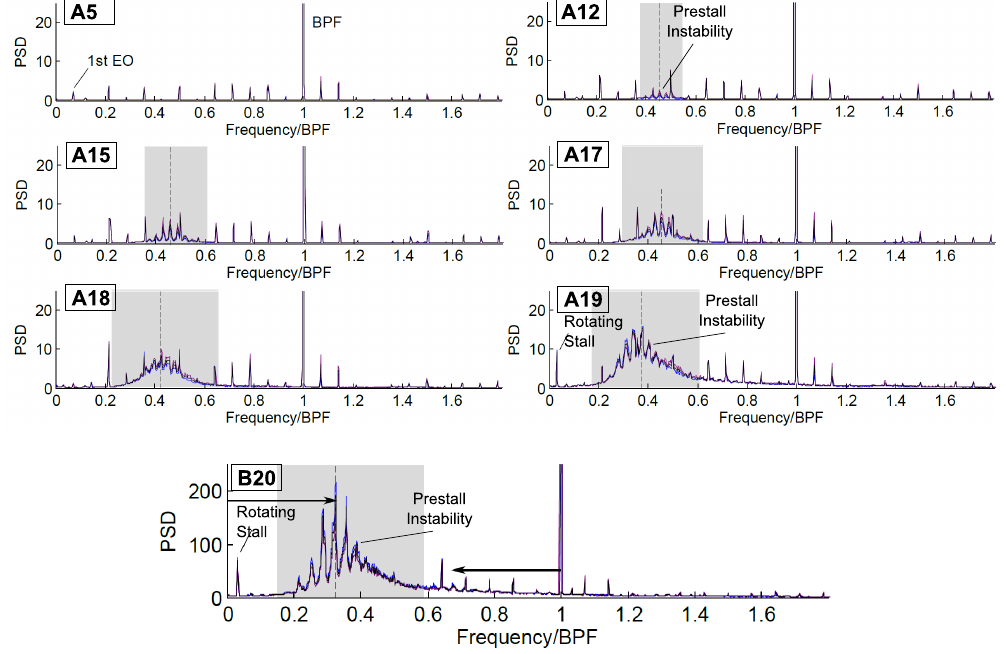
Figure 7. Analysis of the Power Spectral Density (PSD); Development of prestall instability at various operating points for different speeds (BPF: blade passing frequency)